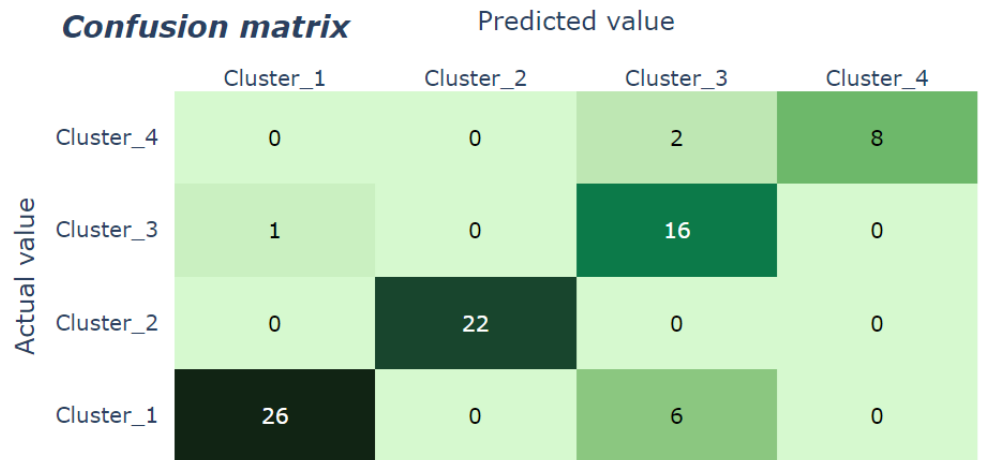
Figure 7. Confusion matrix of UMAP representations of hand-crafted features and tsfresh extraction features using HAC with euclidean